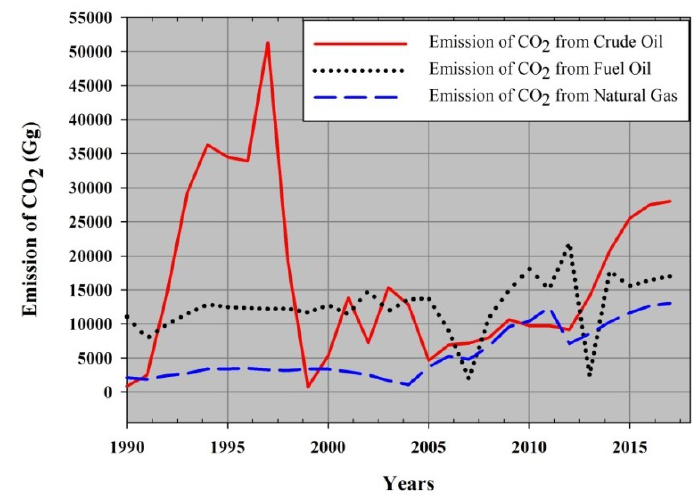
Figure 5. The CO 2 emissions from the consumption of crude oil, fuel oil, and natural gas in electricity generation in Iraq from 1990 to 2017.